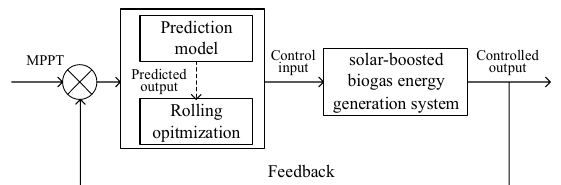
Fig. 4 Block diagram of MPC-based